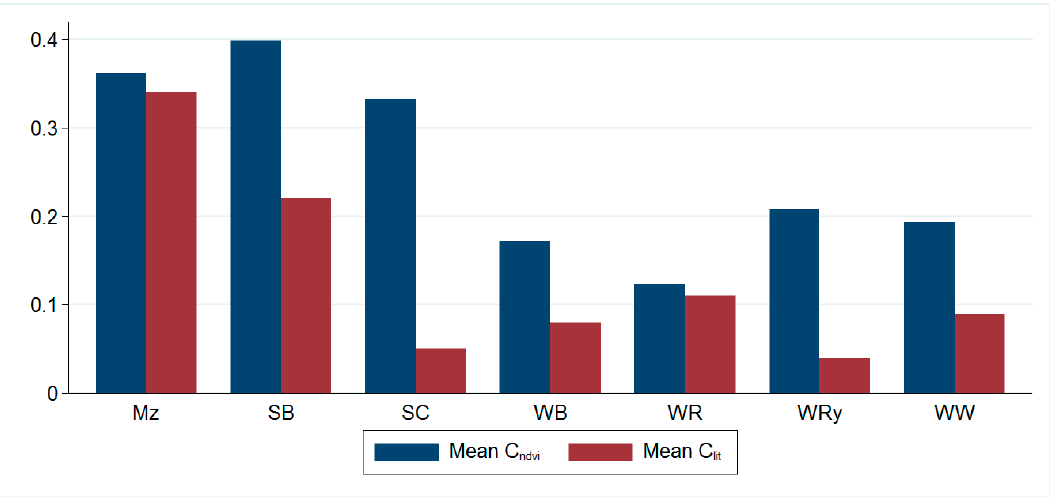
Figure 3. Annual average C factor comparisons between C ndvi and C lit values among different crops. The C ndvi values are aggregated average values of the three considered years (from 2013 to 2016).